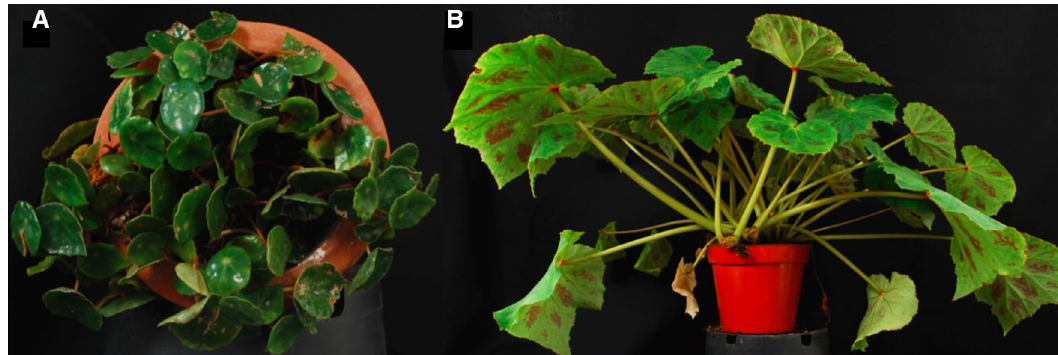
Figure 1. Photographs of study species used. B. conchifolia ( A ) and B. plebeja ( B